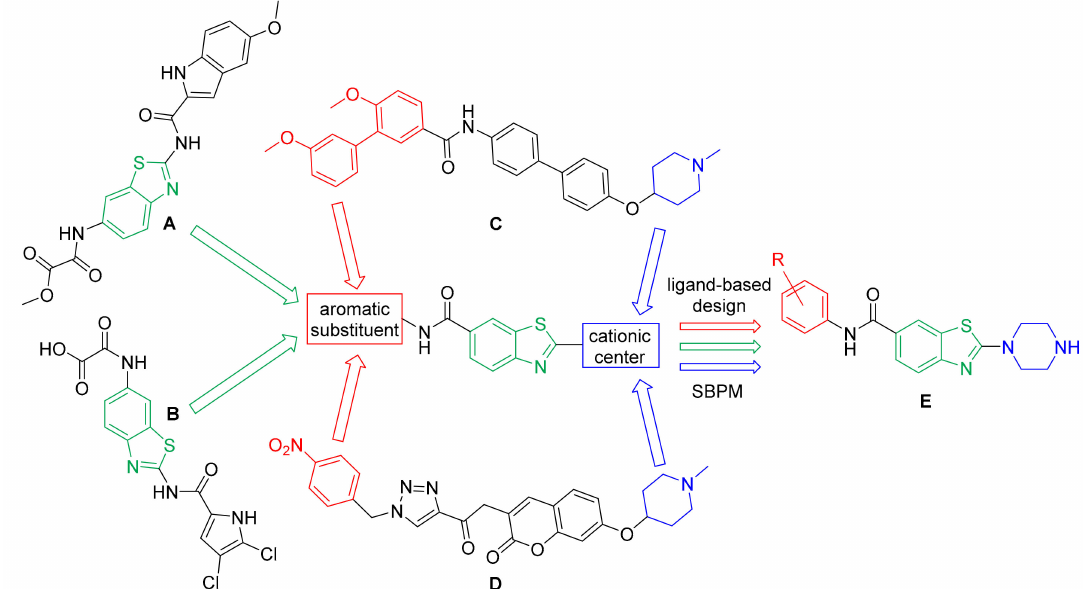
Figure 2. The design strategy started with the known benzothiazole-based Hsp90 C-terminal-domain (CTD) inhibitors A [35] and B [34]. These were combined with the well-established general structure–activity relationships of Hsp90 CTD inhibitors represented by compounds C [29] and D [28]. A new compound of class E was also designed and